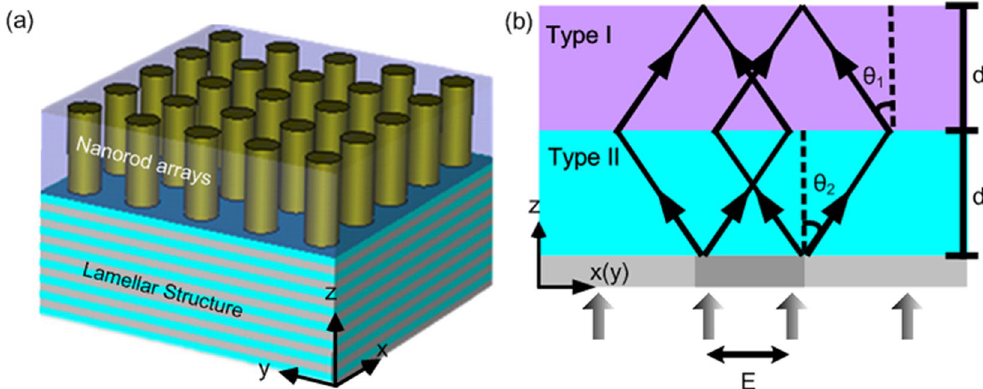
Figure 2. Schematic of the HPEDL and the detecting principle. ( a ) Schematic configuration of the HPEDL consisting of type I (e.g., Au nanorod arrays) and type II (e.g., Ag/SiO 2 multilayers) hyperbolic media. ( b ) The operation principle of the HPEDL. θ 1 and θ 2 are the angles between the Poynting vector (dark arrows) and the optical axis for type I and type II hyperbolic media,